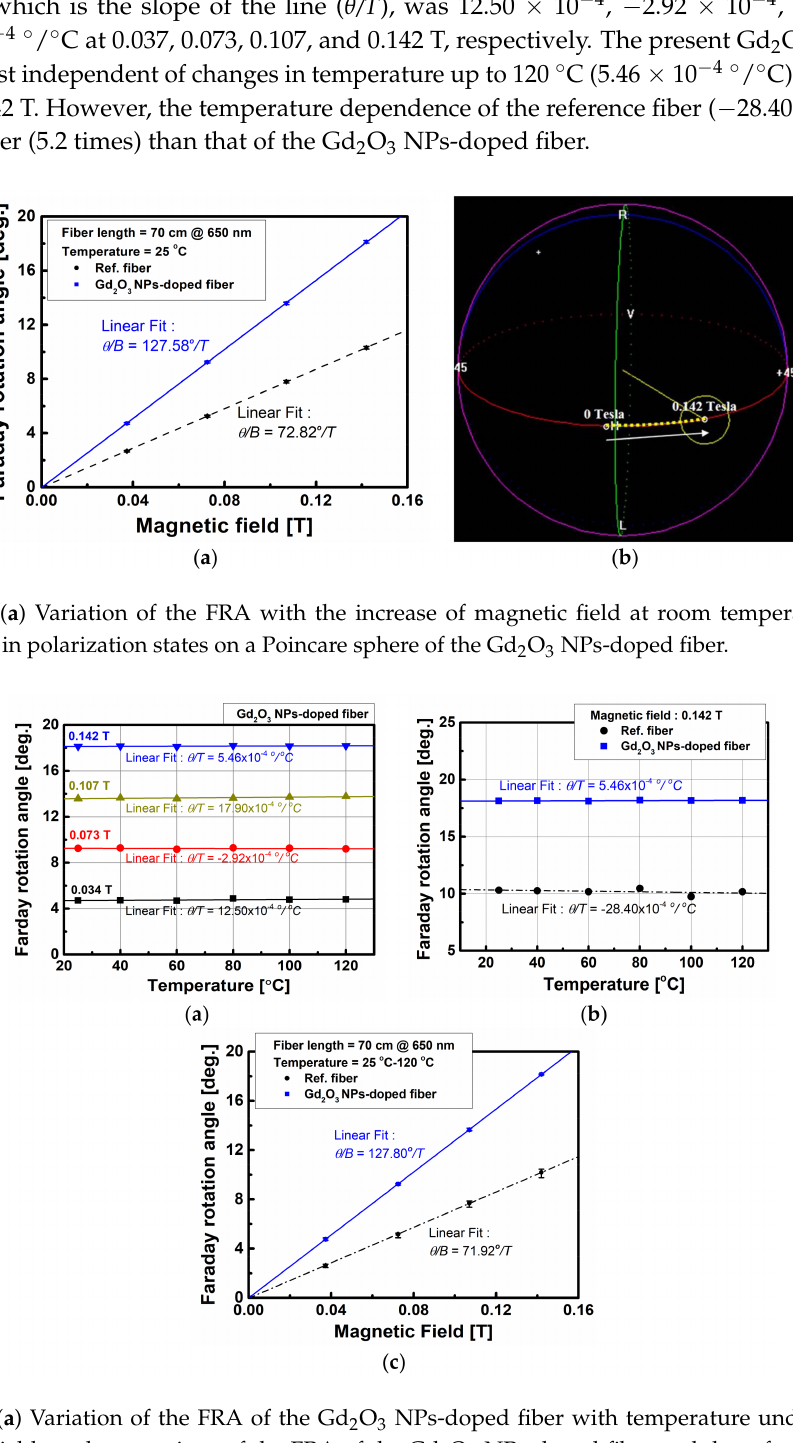
Figure 6. ( a ) Variation of the FRA of the Gd 2 O 3 NPs-doped fiber with temperature under varied magnetic fields and comparison of the FRA of the Gd 2 O 3 NPs-doped fiber and the reference fiber; ( b ) with temperature under 0.142 T; and ( c ) with magnetic field under varied temperature. The lines shown in the figures were obtained by the linear regression